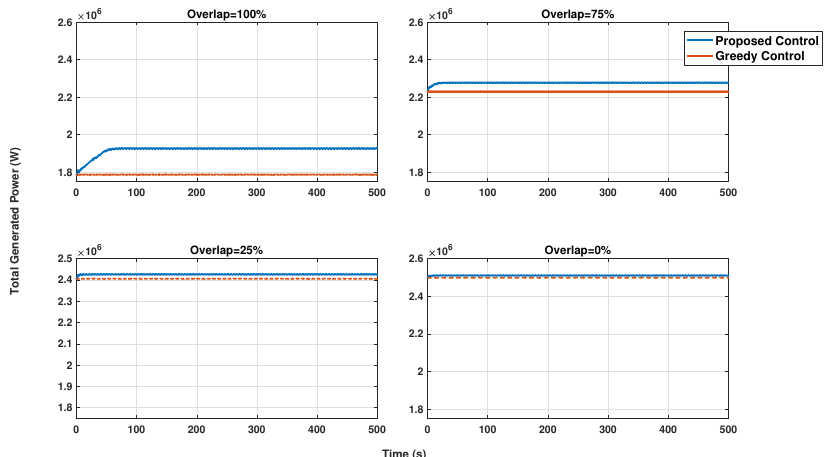
Figure 10. Comparison between the proposed control scheme and the non-cooperative (Greedy control) scheme proposed in [26] for total power maximization under different wind directions.